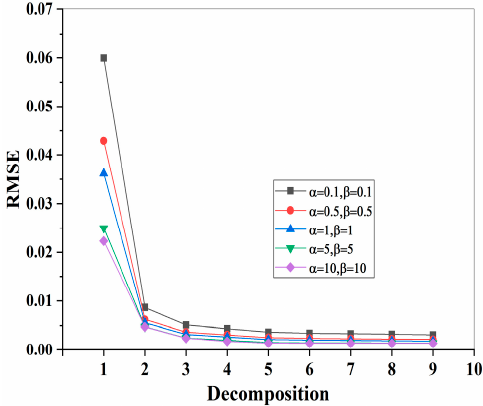
Figure 9. RMSE with different decomposition levels.